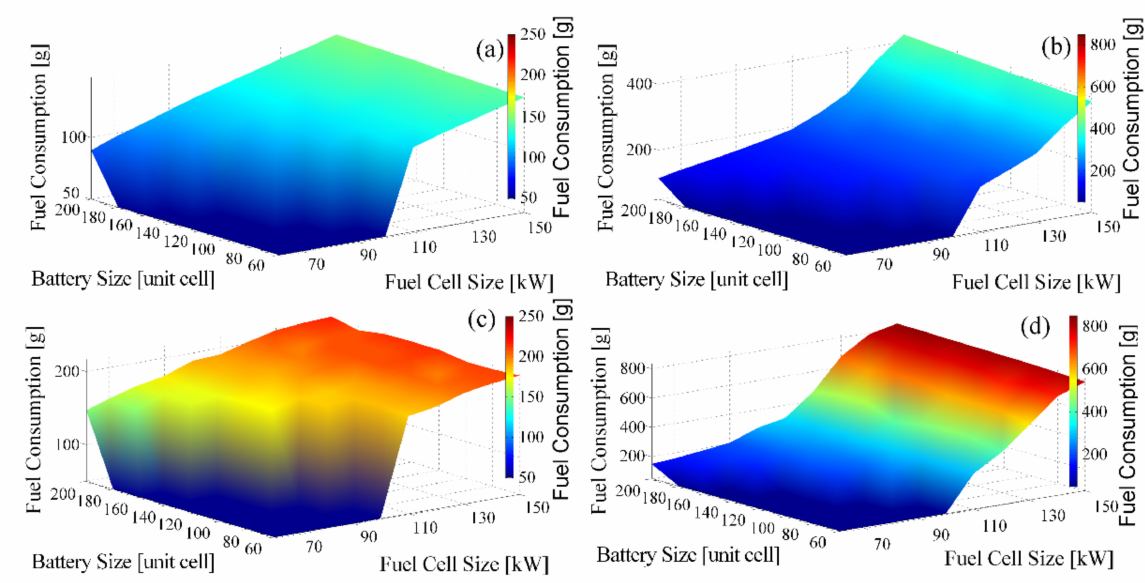
Figure 3. Fuel consumption maps under driving cycles with different SOC ranges: ( a ) FTP-72 driving cycle, SOC 0.2–0.8; ( b ) FTP-72 driving cycle, SOC 0.5–0.6; ( c ) US06 driving cycle, SOC 0.2–0.8; ( d ) US06 driving cycle, SOC